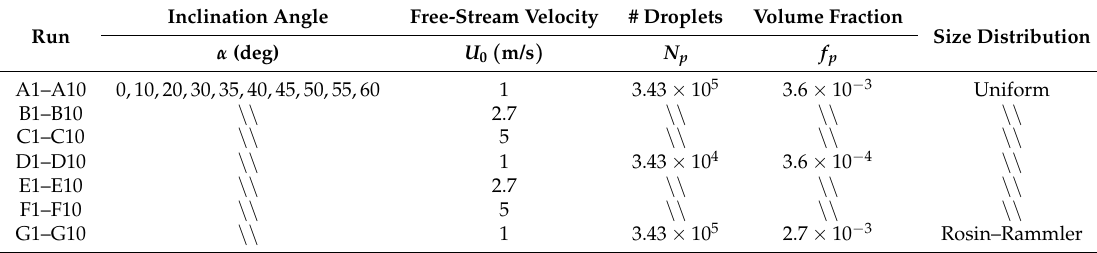
Table 1. Parameters of the simulations. The computational domain has N = 2.5 × 10 6 grid